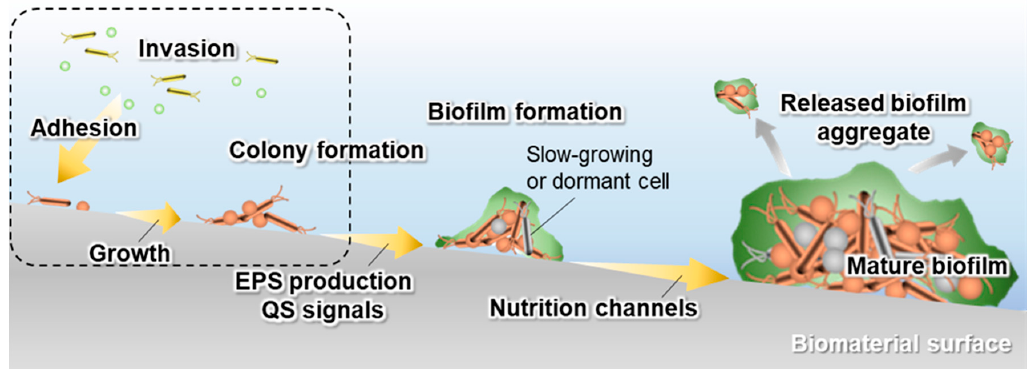
Figure 1. Schematic diagram of the biofilm formation process. The dashed area represents the initial stages of biofilm formation.